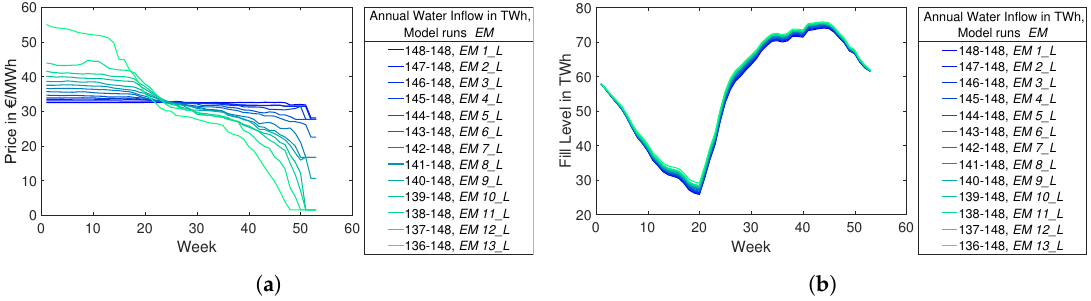
Figure 5. Impact of the expectation of less water inflow than the one that materializes. ( a ) electricity prices with different model runs regarding uncertain water inflow; ( b ) fill level with different model runs regarding uncertain water inflow.